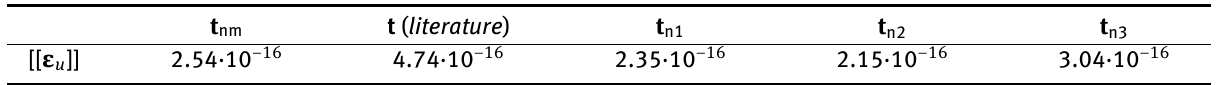
Table 6: Norm of the unbalanced residual normalized internal forces vectors of the Snelson’s X beam with three